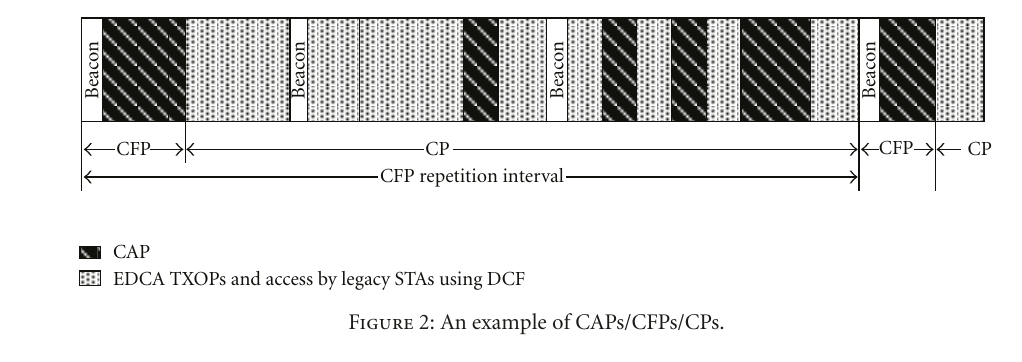
Figure 2: An example of